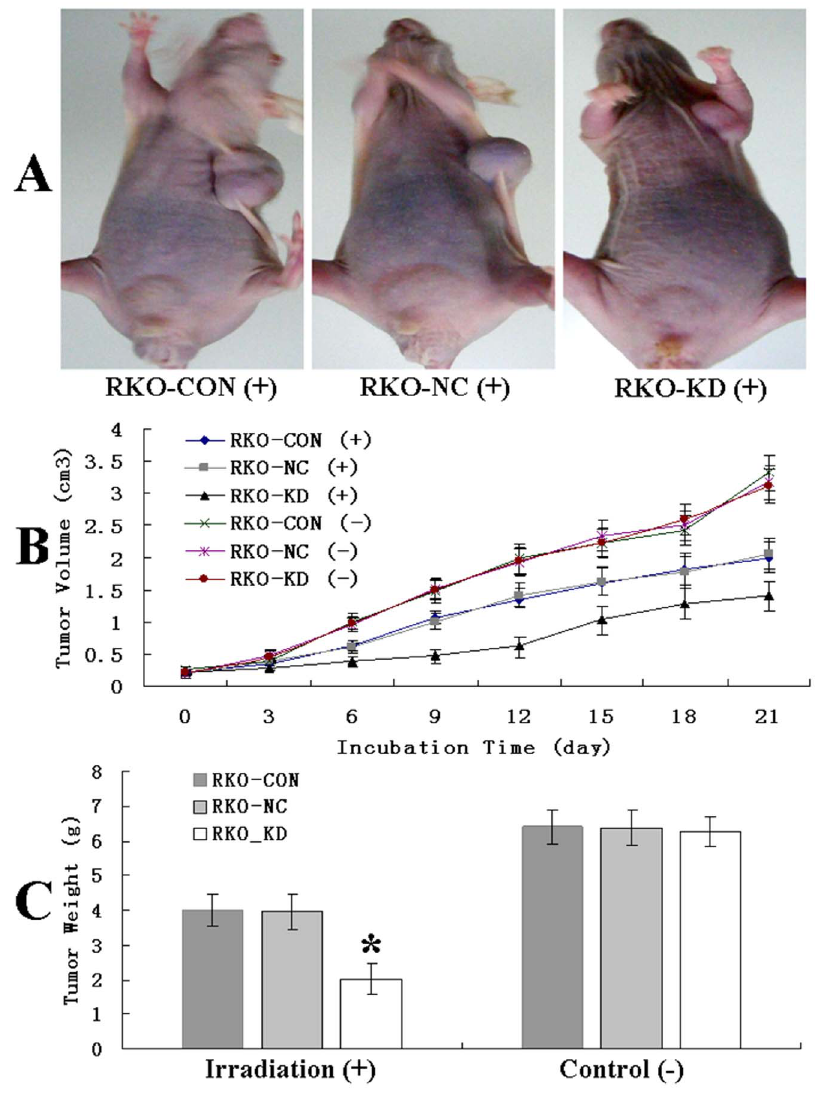
Figure 4. Down-regulation of ABCC4 Expression Significantly Enhanced Irradiation-induced Suppression of Tumor Growth in Xenograft Model. A: Three representative mice following a total dose of 10Gy irradiation. B: Tumor volume curve (cm 3 ) in xenograft models of RKO cells with or without ABCC4 knockdown following irradiation ( P , .05; Error bars, SD) or not ( P . .05) in a time-dependent manner. C: The mean tumor weight (g) in xenograft models of RKO cells with or without ABCC4 knockdown following irradiation (* P , .05 for both; Error bars, SD) or not ( P . .05) at the end of the observation.